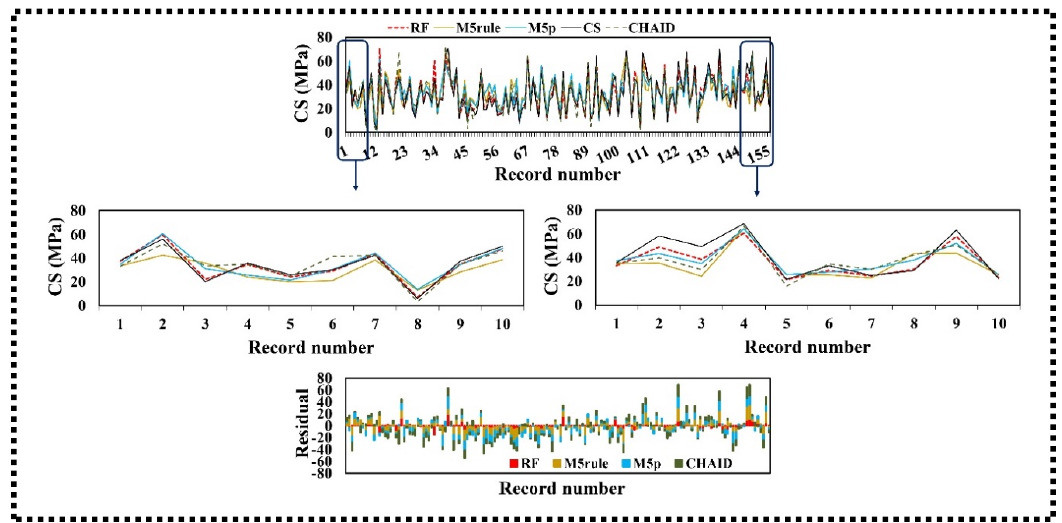
Figure 5. Time series and residual plots of the testing phase of the classification-based regression methods for CS estimation.